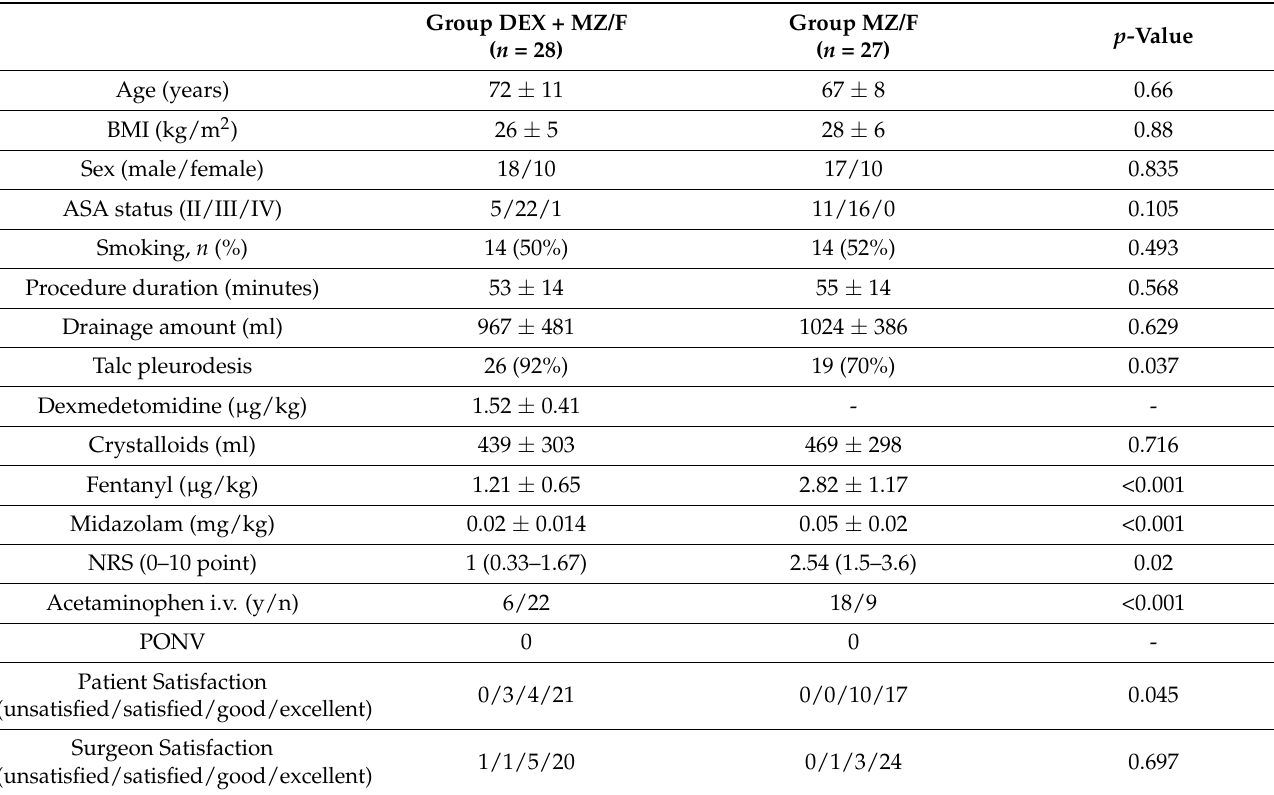
Figure 1. Flow Diagram of Study Participants. Table 1. Demographic and Procedural Clinical